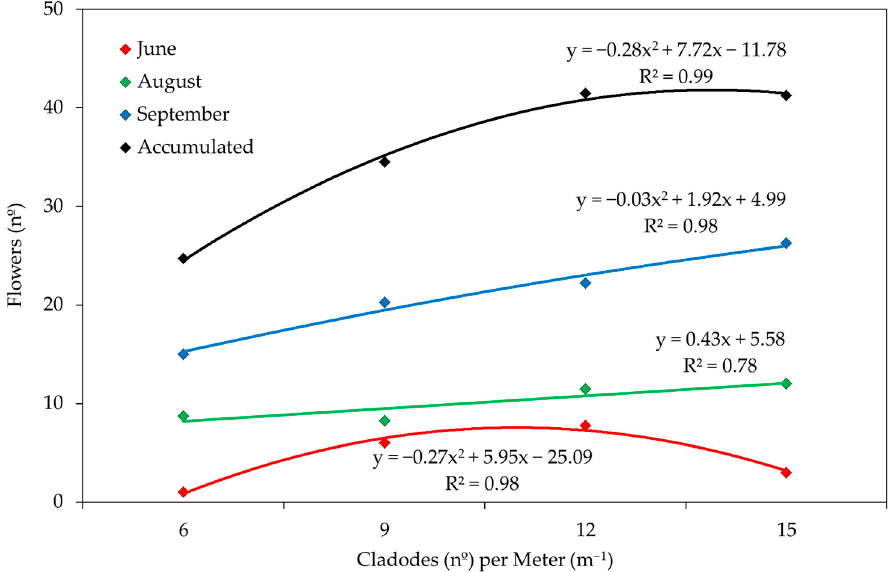
Figure 2. Flowering levels in response to pruning intensity. In red, the first wave; in green and blue, the second and third waves. In black, the total accumulated level of flowering.